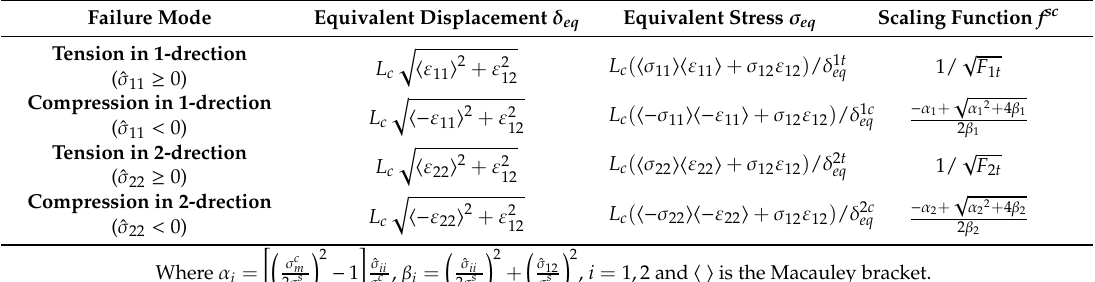
Table 3. Equivalent displacement, equivalent stress and scaling functions in each failure